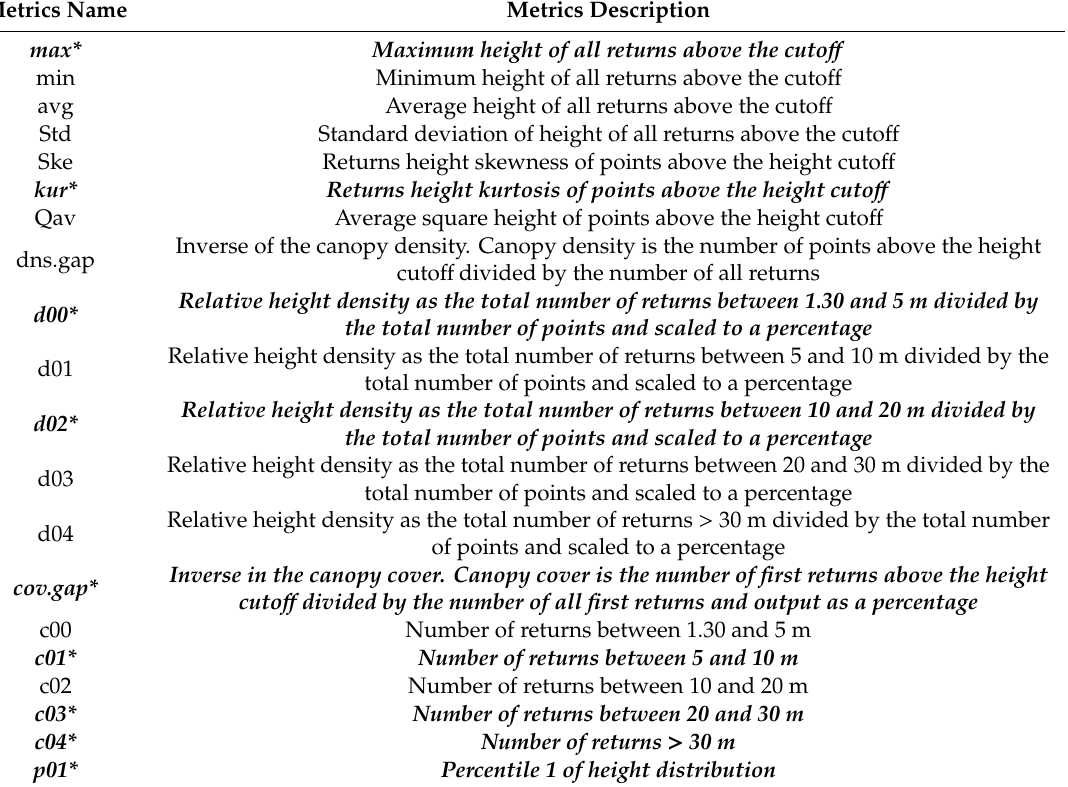
Table A2. ALS metrics description. Metrics for which a variable importance was calculated are in bold and italics and indicated with